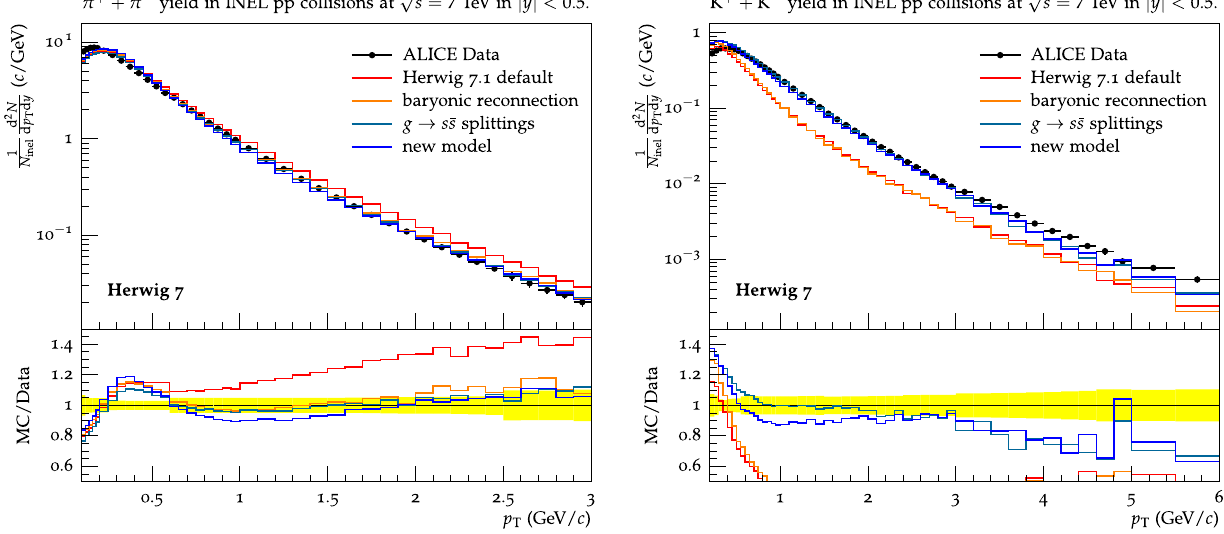
√ s = 7TeV [25] in the very central rapidity region